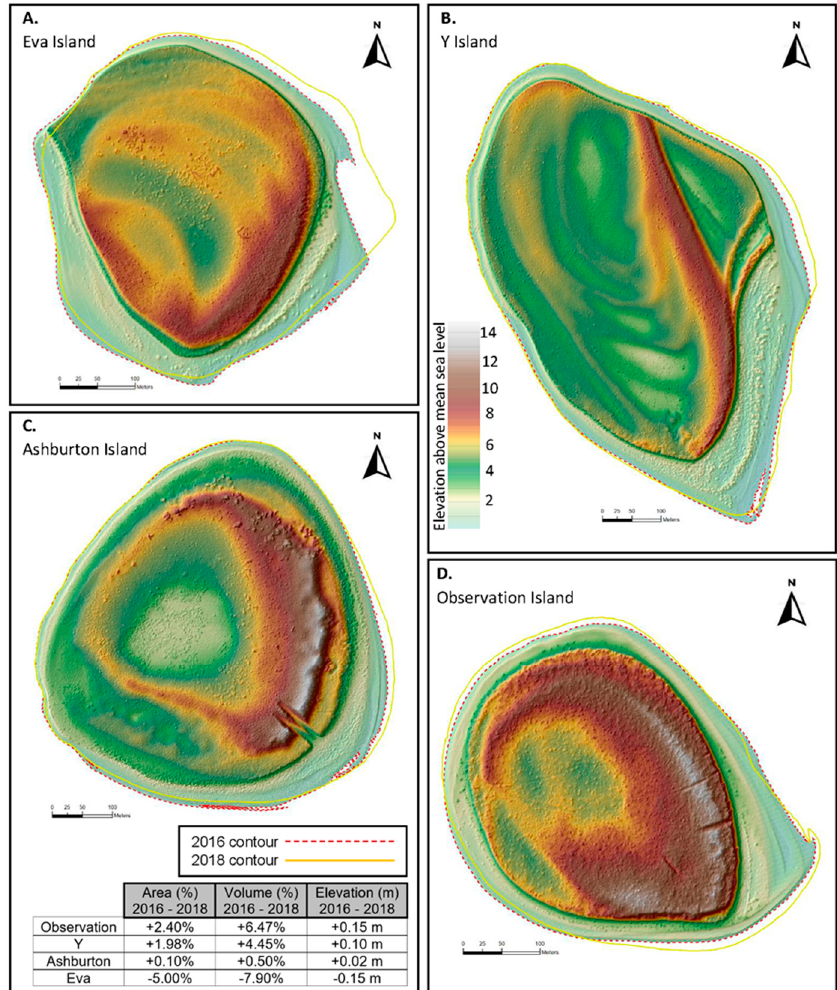
Figure 4. Changes in island area, island volume, and average island elevation for ( A ) Eva, ( B ) Y, ( C ) Ashburton, and ( D ) Observation islands (between 2016 to 2018) using the 0.5 m digital elevation models (DEMs). The 2016 island area is defined as the HAT contour marked by the red dashed line and the 2018 island area marked as the yellow solid line. High-resolution LiDAR was captured during October of 2016 and 2018.